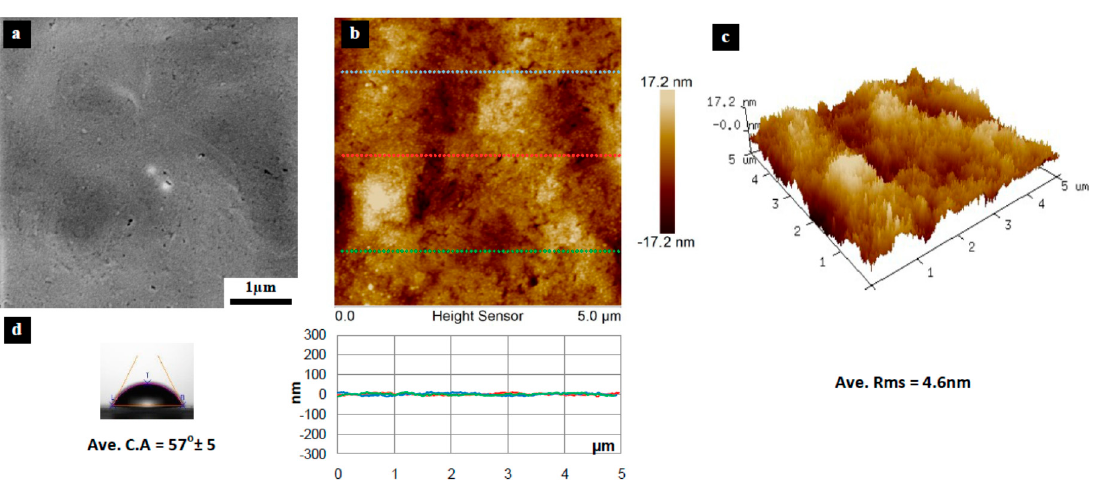
Figure 5. Surface characteristics of as received PVDF 1 substrate (10 nm pore size), ( a ) SEM micrograph; ( b ) 5 × 5 µm 2 AFM image (top) and three section profiles (bottom) with an average RMS equal to 4.6 nm; ( c ) 3D profile for the selected area; ( d ) surface contact angle (CA) with an average equal to 57 ◦ ± 5 ◦ .